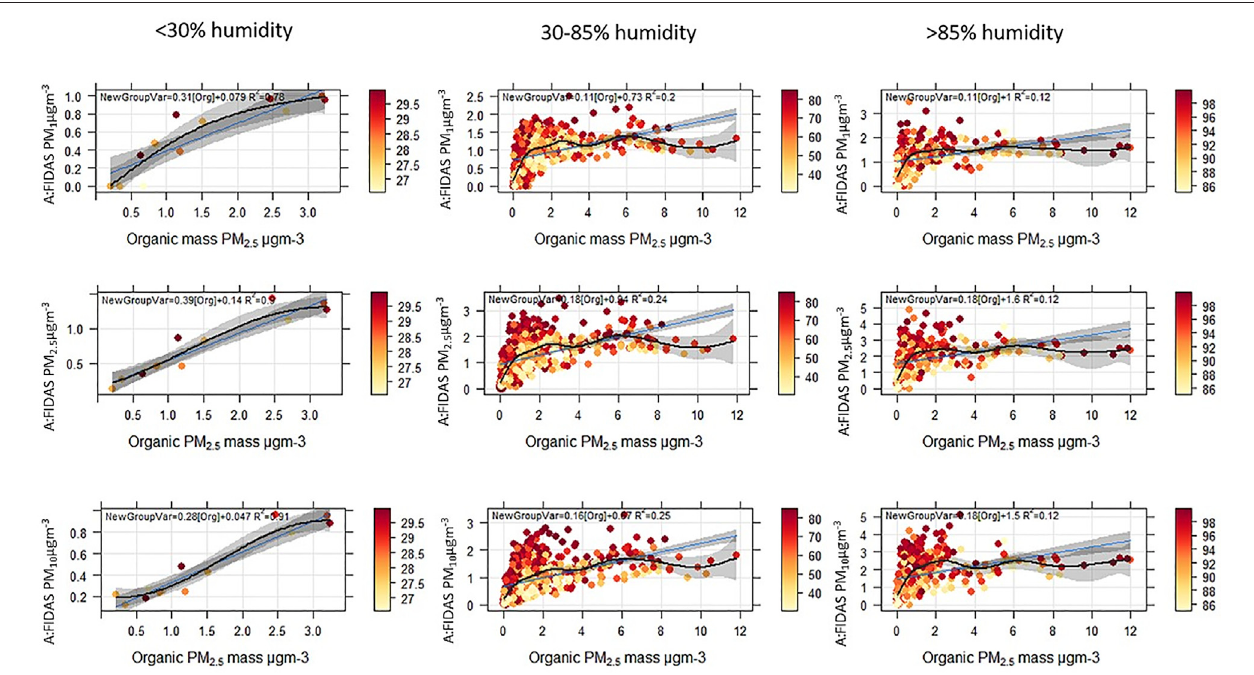
FIGURE 6 | Examples of Altasense PM/reference PM concentrations from sensor A by organic concentrations from ACSM by humidity at different humidity intervals. Linear equation of ratio by organic mass concentration is shown on the plot.